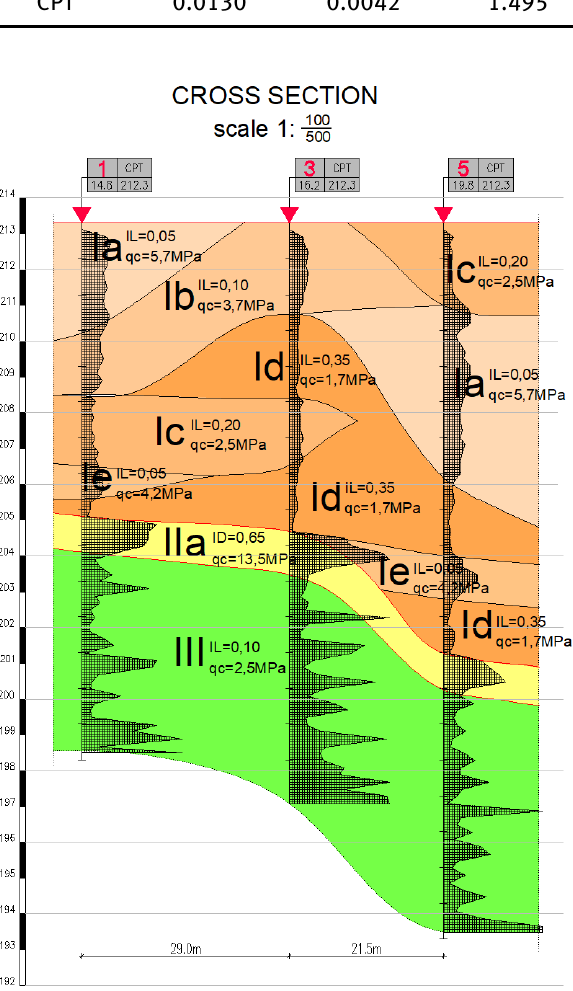
Figure 2: The representative geotechnical cross-section